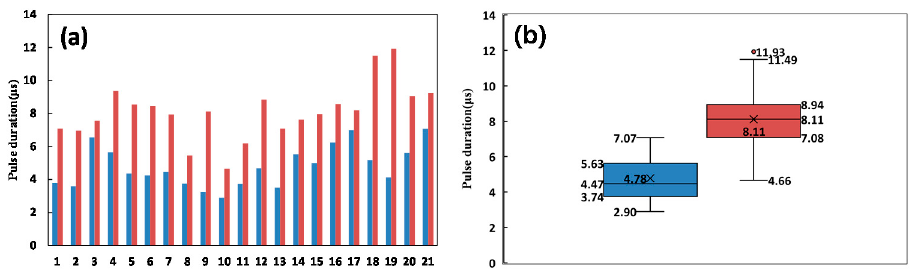
Figure 10. Average pulse durations of PCP clusters and IPCPs. ( a ) Statistics of each case. ( b ) Overall statistics of all cases. The blue is the PCP clusters and the red is the IPCPs.